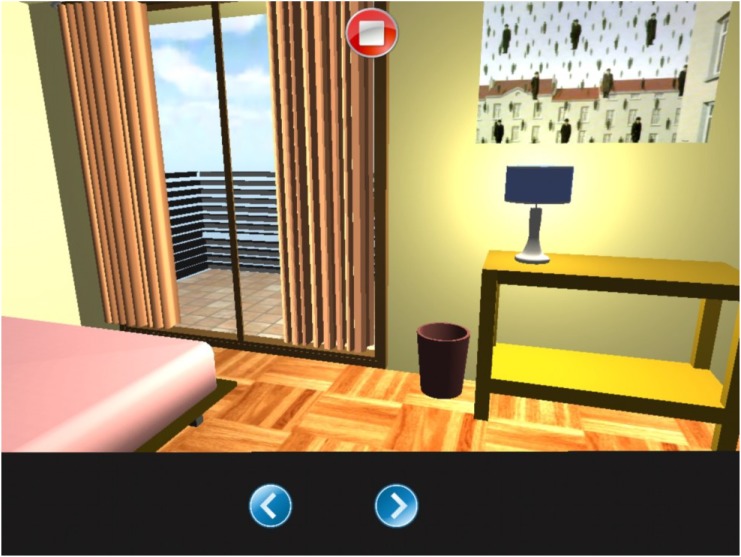
Exploration task.